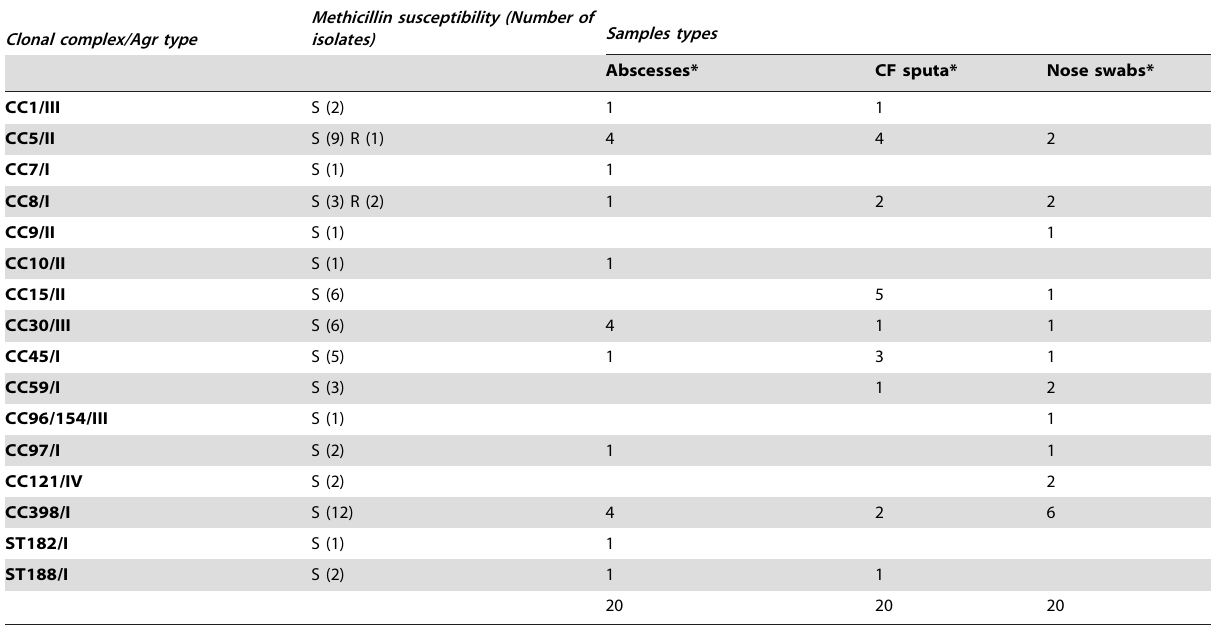
Table 1. Characteristics of Staphylococcus aureus isolates.